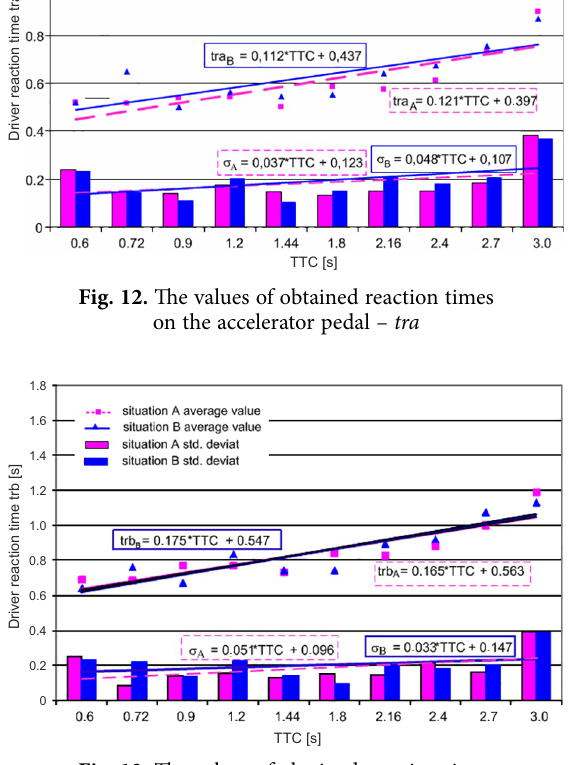
Fig. 13. The values of obtained reaction times to the brake – trb